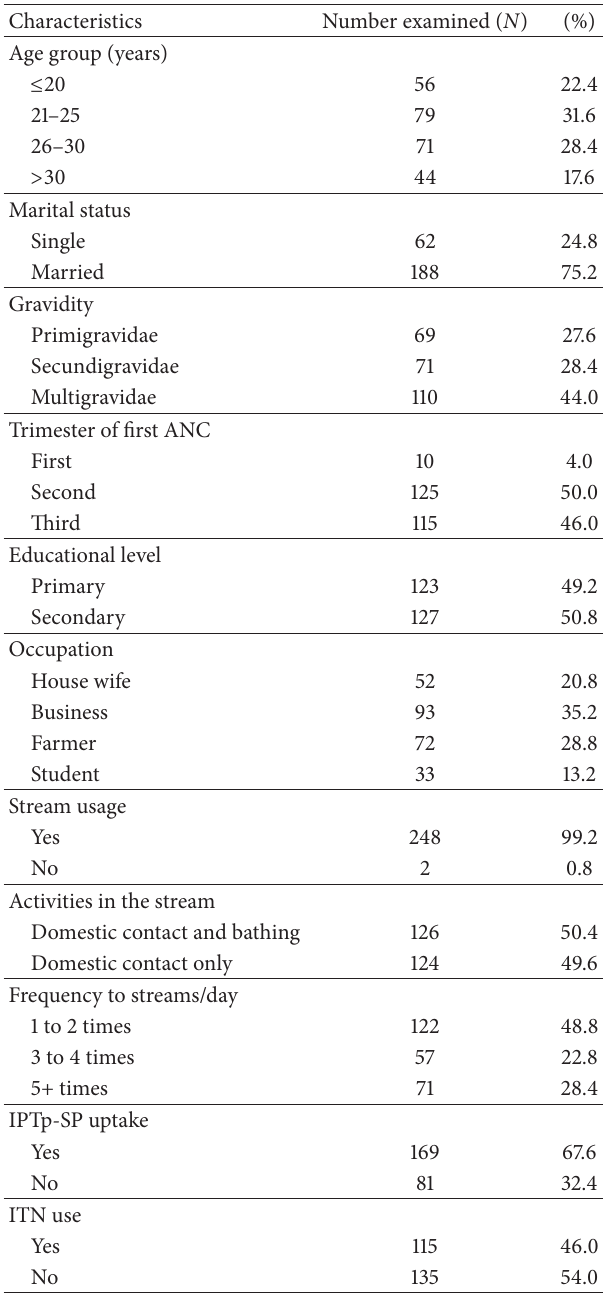
Table 1: Characteristics of the study